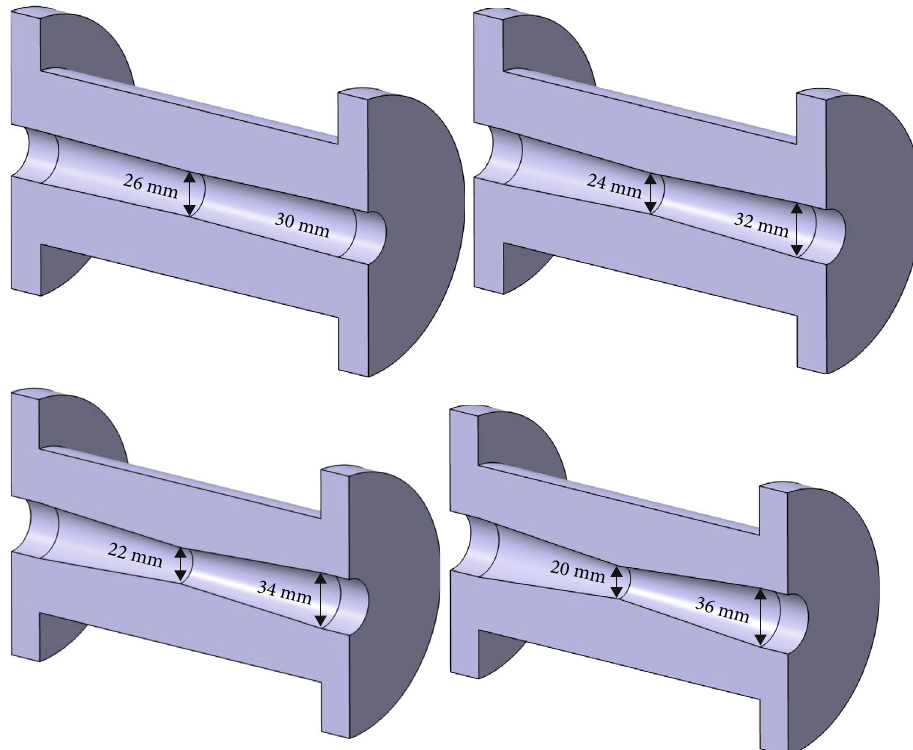
Figure 12: The new inner-varying con fi guration with di ff erent geometry